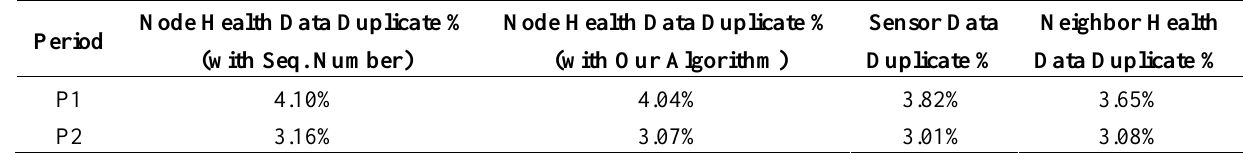
Table 4. Percentage of duplicate packets received for each packet type per time period (𝜕𝑇 = 2 min) during the two XMesh evaluation